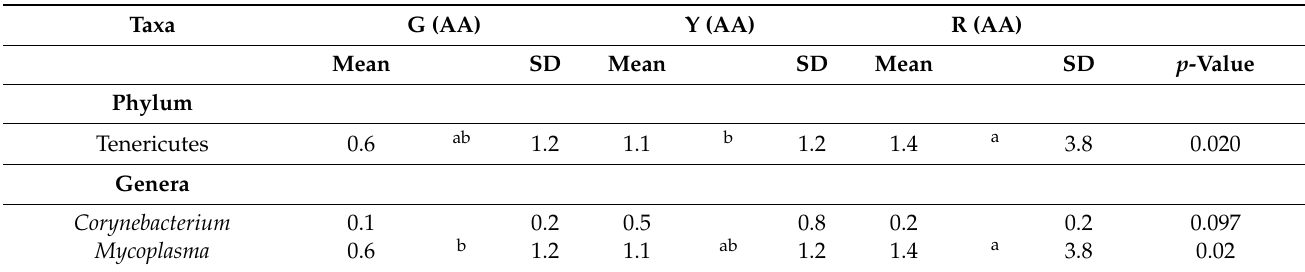
Table 3. Statistical comparison of the mean abundances of bacteria at a phylum and genus taxonomic levels measured in blood sampled from lactating cows classified as healthy (G), at risk (Y) and with subclinical mastitis (R) on the basis of total somatic cell count (SCC) and differential somatic cell count (DSCC). Only taxa which significantly differed with the Kruskal–Wallis non-parametric test are reported.